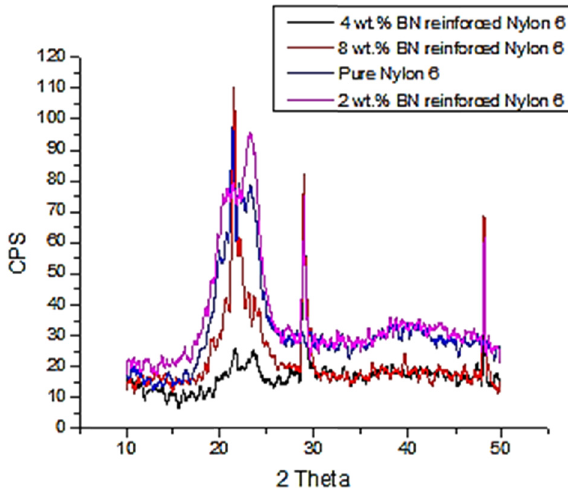
Figure 12: XRD plots of nylon 6 and